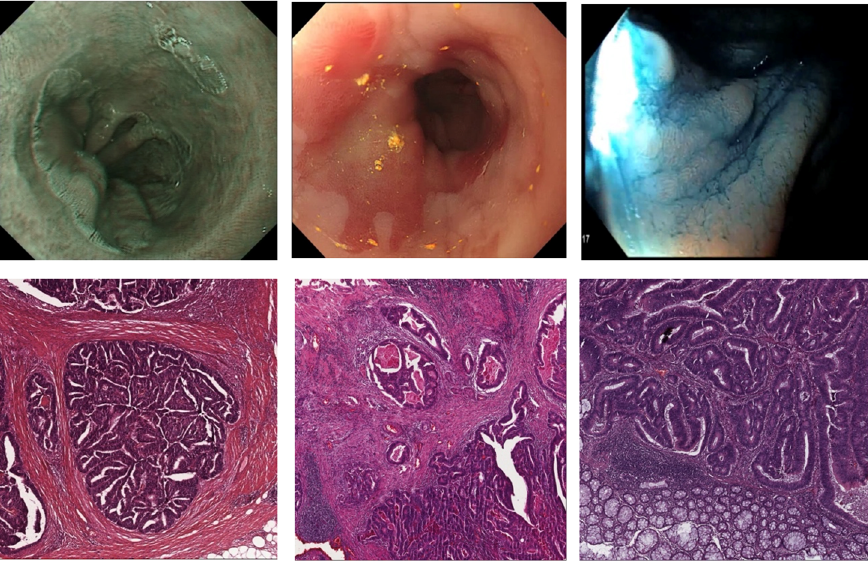
Figure 2. Sample images from a CRC dataset: ( top row ), endoscopy images, and ( bottom row ), histological whole slide images (WSI).